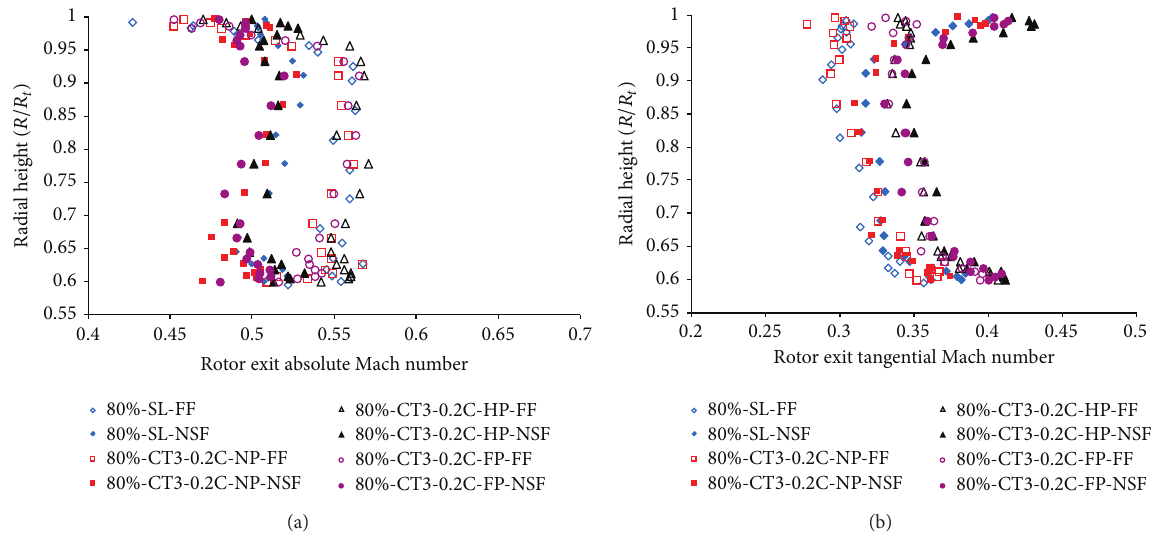
Figure 11: Comparative variations of (a) rotor exit absolute and (b) tangential Mach number for the solid casing and three configurations of casing treatment and plenum chamber at full flow (FF) and near stall flow (NSF) conditions.